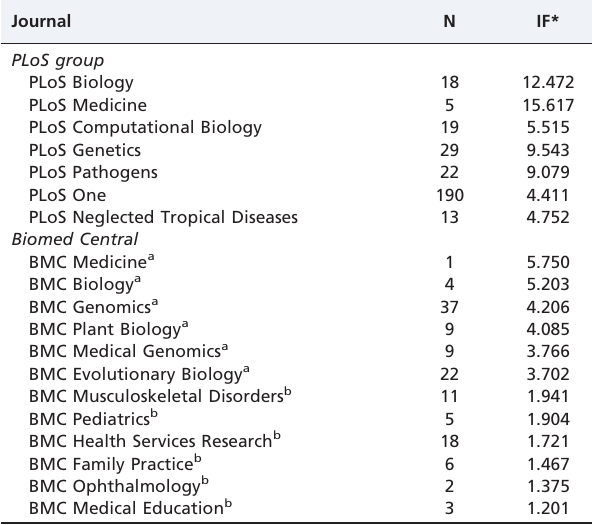
Table 1 - Selected journals with their respective numbers of articles analyzed and impact